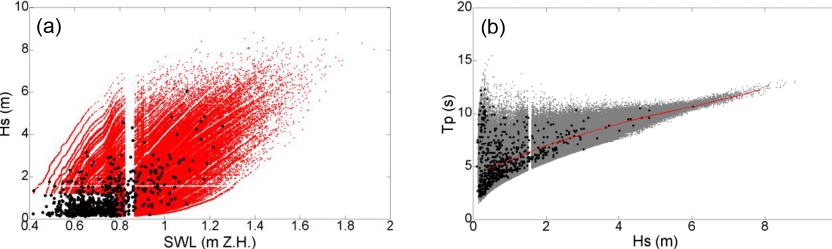
Figure 7. (a) On the left are the results of Monte Carlo simulation for variables H s and SWL based on 6 common years between SWL data and H s data (Candhis). Declustered data are in black, simulated data (10000 years) in red. (b) On the right are the results of Monte Carlo simulation for variables H s and T p . Black dots are declustered data. Grey dots are simulated data. In red is the median of the periods simulated given H s .